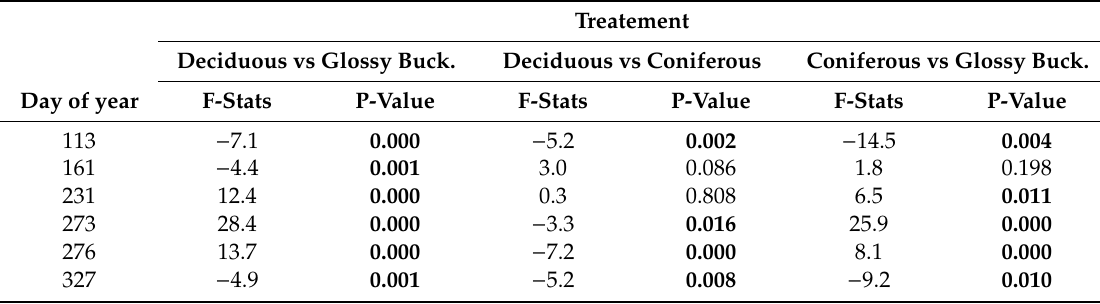
Table A1. Comparisons of endmember mean values: t-tests F-stats and P-values for each pair of endmember and the date of image acquisition. P-values in bold indicate a significant difference in mean between two groups for a given date. To account for the multiplicity of the test at each date (N = 3), we applied the Bonferroni correction. P-values below 0.017 (0.05/3) were considered as significant.